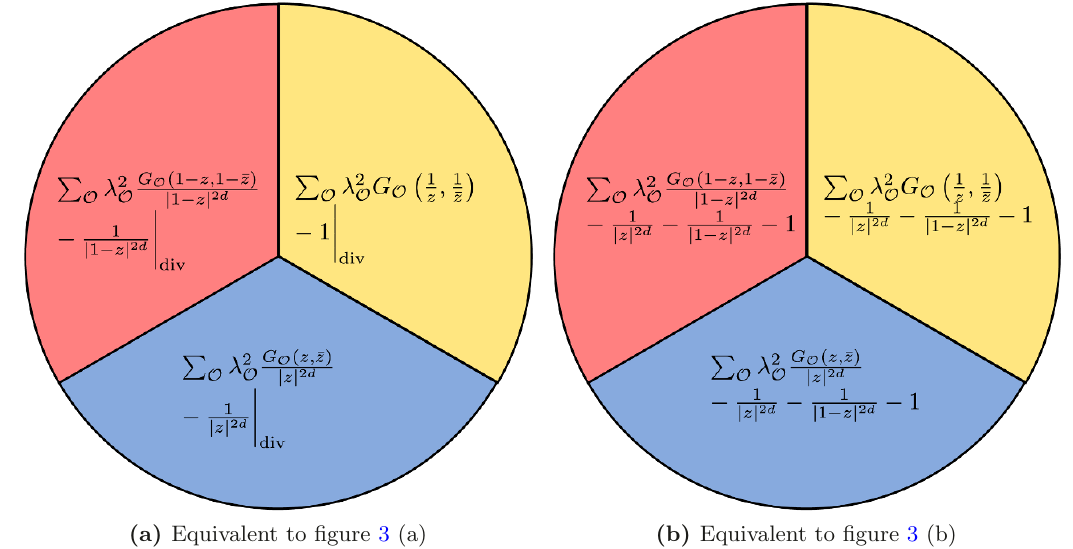
Figure 4. The cartoons obtained by splitting figure 3 into s , t and u channel regions. In both cases, the identity block is not annihilated. A divergence subtraction is now no longer the same as a full subtraction. In particular, removing div everywhere in the left blob would not compute a physical